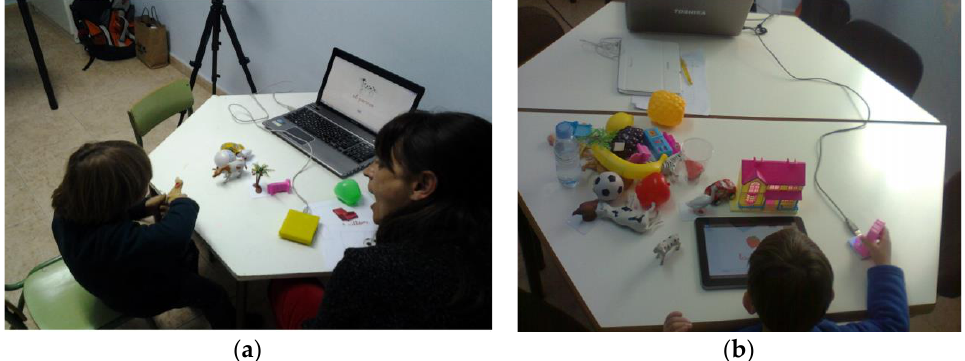
Figure 13. Techear-child session with TUI ( a ), Self-learning using a multitouch interface ( b ) [30].